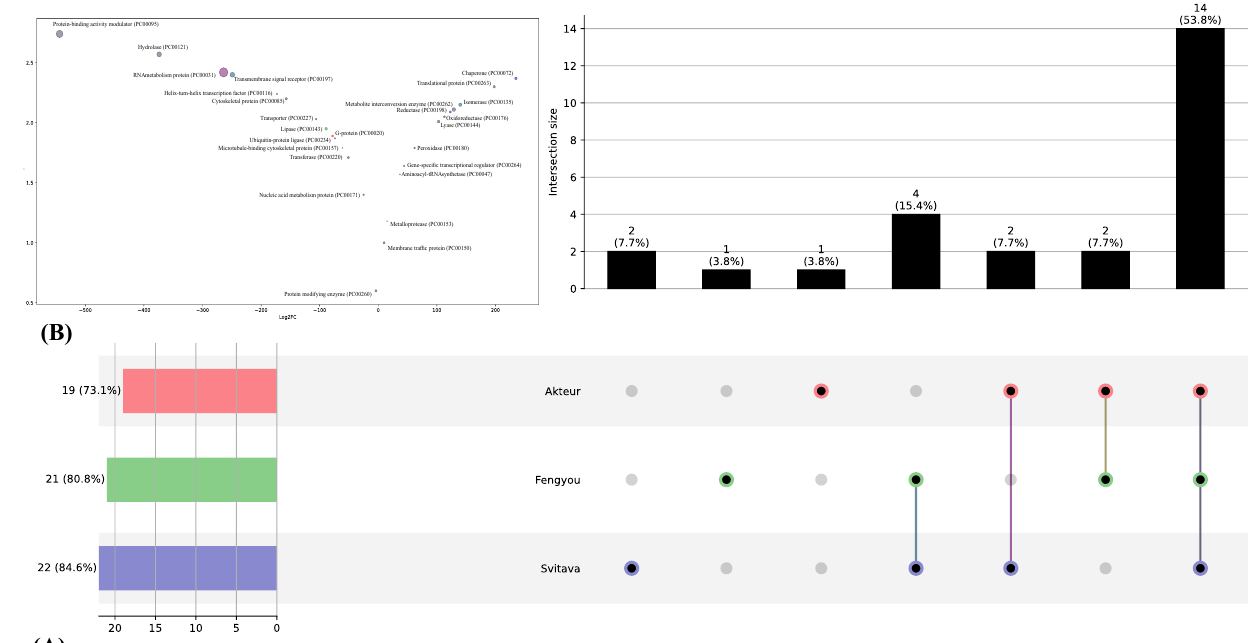
Figure 5. The functional significance of the shared and genotype specific DETs. ( A ) UpSet plot of the intersection among of the enriched PANTHER protein classes in the three genotypes. ( B ) A bubble plot of intersected enriched PANTHER protein classes expressions and gene ontology (GO) classification.